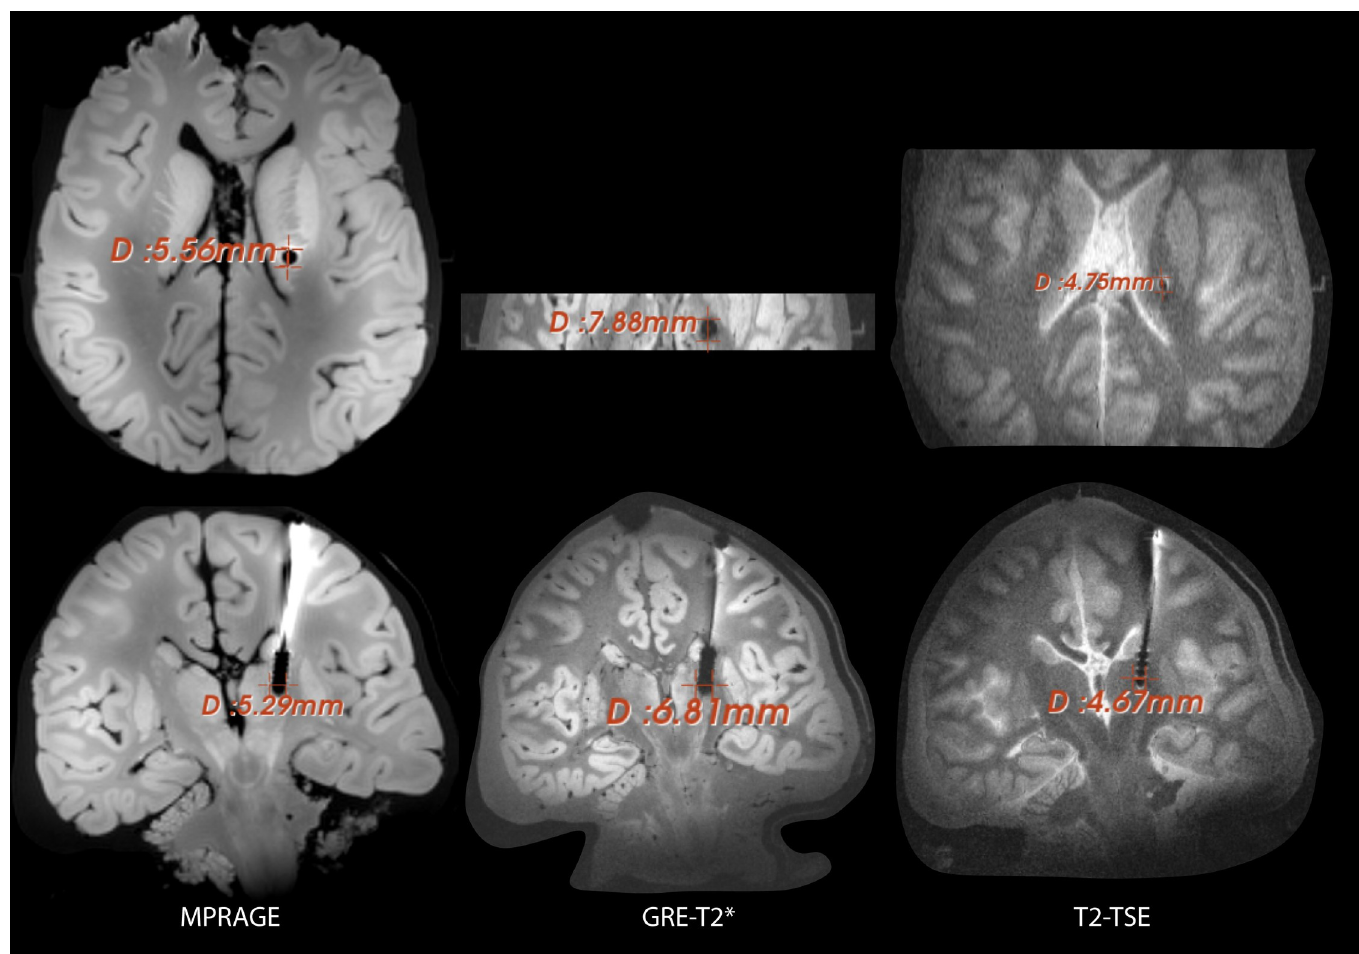
Fig 7. Image artifact measurements. Image artifact around the DBS lead implanted into the cadaveric brain. Each column represents the artifact in transverse and coronal planes for sequences detailed in Table 2. The artifact size (width) around electrode contacts is reported for each case. Scans were performed with a lead-only system, with the extra-cranial portion of the lead looped around the bur